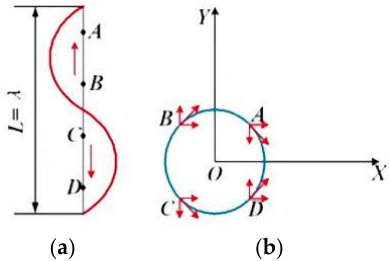
Figure 3. Current distribution on the spiral at t = T/4. ( a ) the amplitude and direction of current on the unfolding spiral and ( b ) the amplitude and direction of current on circle